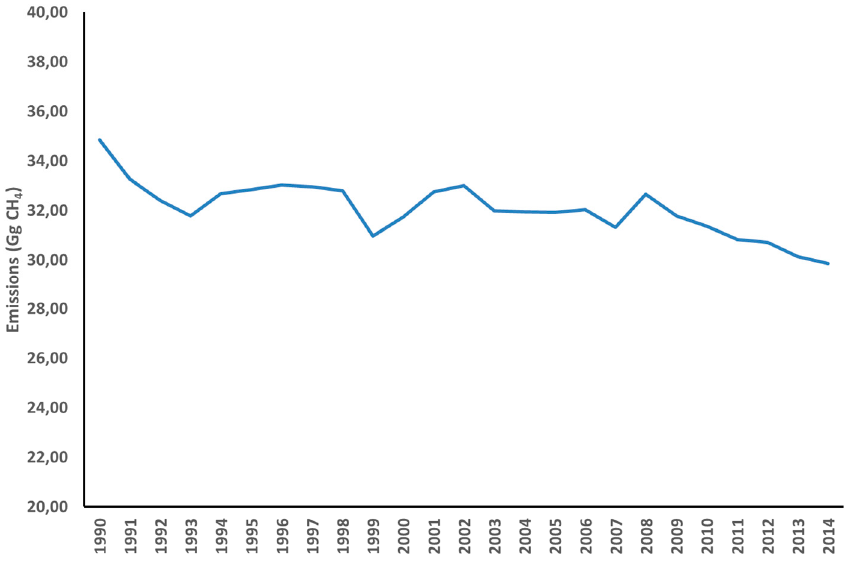
Figure 5. Enteric emissions (Gg CH 4 ) for South African goats from 1990 to 2014.